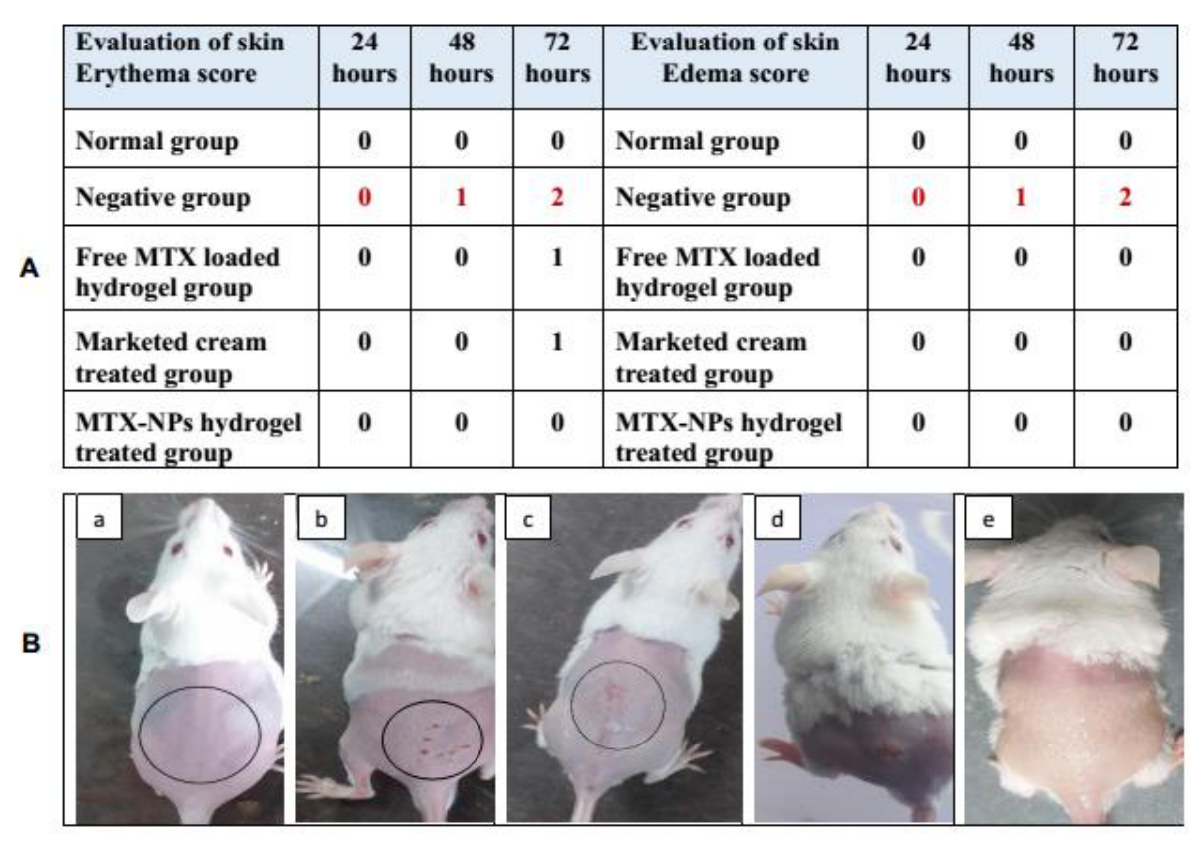
Figure 9. ( A ) Skin irritation scores for erythema and edema at 24, 48 and 72 h, ( B ) Visual representation of skin irritation for different treatments, i.e., ( a ) Normal group ( b ) 0.8% formalin treated as a negative control, ( c ) Treated with free MTX-loaded hydrogel, ( d ) Treated with marketed cream ( e ) Treated with MTX - NPs loaded hydrogel.